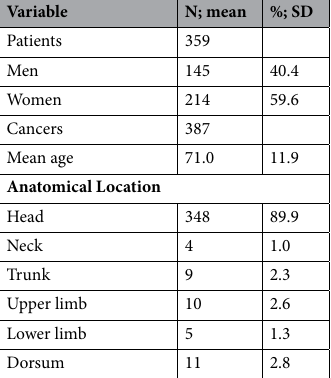
Table 1. Study group characteristic. SD standard